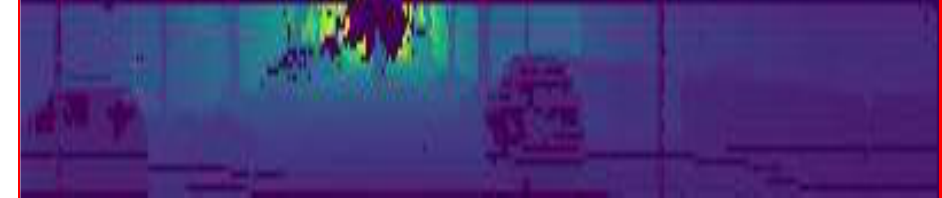
Figure 3. LiDAR point clouds projected onto a panoramic image.